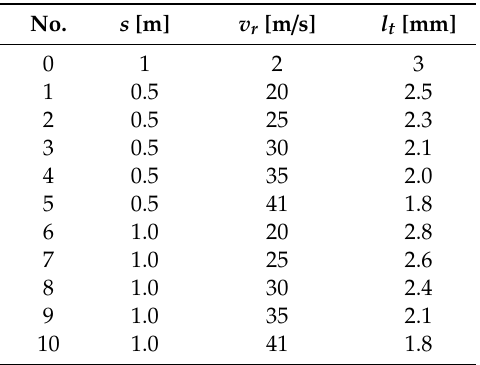
Figure 7. Dependence of the cut width ( l t ) of the relative speed ( v r ) and the thickness of the metal band TO ( s ). Table 8. The dependence of the width of the cut, on the relative speed of the TO and on the thickness of the metal